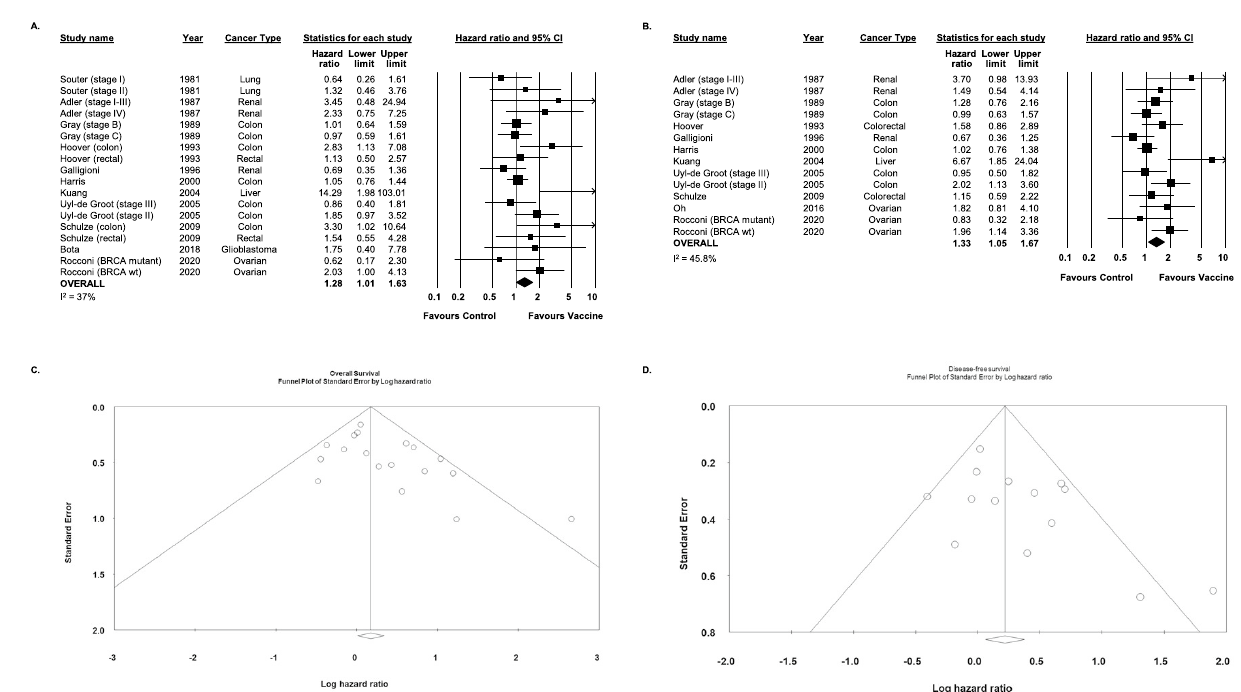
Figure 2. ( A , B ) Hazard ratio and accompanying 95% confidence interval for overall survival ( A ) and disease- free survival ( B ) in randomized control trials of patients treated with autologous whole cell vaccines for solid tumors. ( C ) Funnel plot for studies reporting on overall survival. ( D ) Funnel plot for studies reporting on disease-free